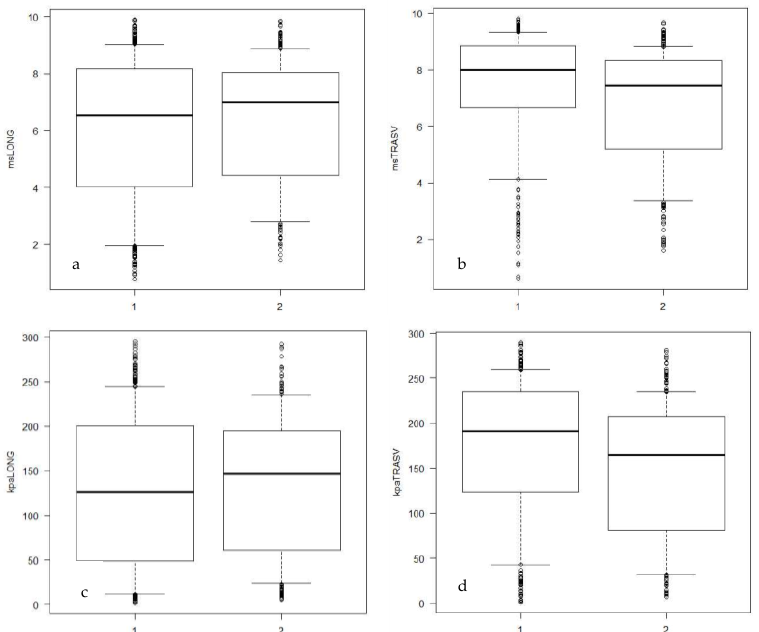
Figure 2. ( a – d ): Box-and-whiskers plots showing the distribution of the variables velocity (m/s) and Young’s modulus (kPa) in longitudinal and transverse scan. msLONG: velocity in logitudinal scan; kPaLONG: Young’s modulus in longitudinal scan; msTRASV: velocity in transverse scan; kPaTRASV: Young’s modulus in transverse scan; 1: Group H; 2: Group P.